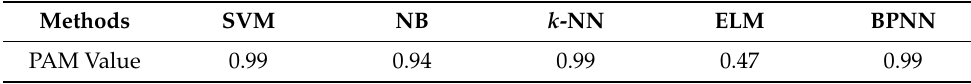
Table 2. PAM performance comparison of each recognition